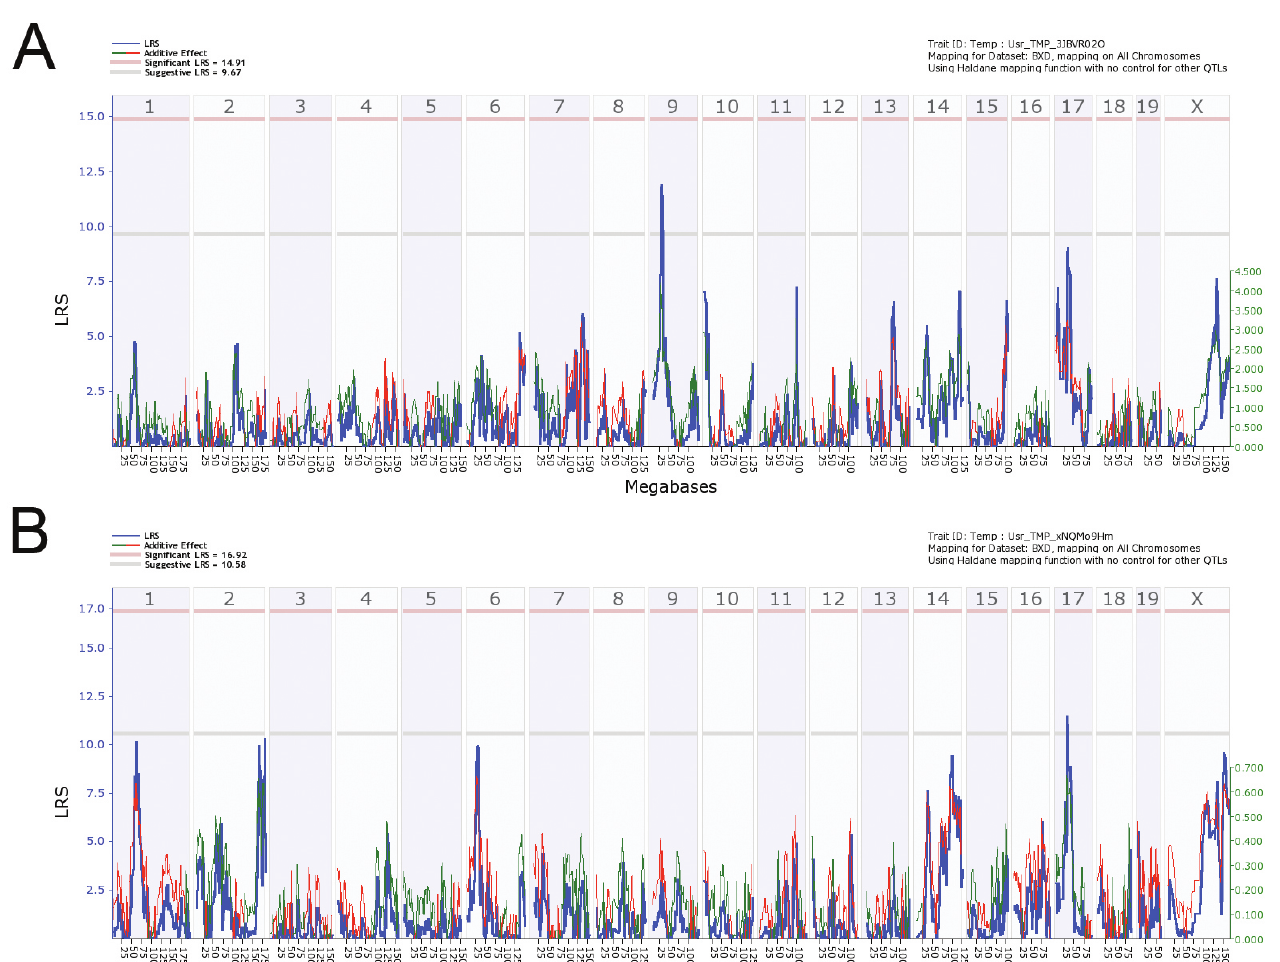
Figure 8. Comparison of preliminary genome-wide QTL mapped traits associated with differential response of BXD strains to aerosolized MA-EBOV. Interval mapping of percent weight loss at death (a) and maximum disease score (b) of BXD strains post-exposure to aerosolized MA-EBOV. Suggestive preliminarily QTLs were mapped. Proximal chromosome 9 is associated with percent weight loss at death (a) and proximal Chromosome 17 is associated with maximum disease score (b). (c) Preliminary QTL comparison of the three mapped traits associated with differential response to EBOV across BXD strains used. Chromosomes 17 and X are preliminary QTLs common for all three traits; chromosome 6 is most significant and associated with both differential survival and maximum disease score; chromosome 9 is associated with percent weight loss at death. Mouse chromosomes are depicted on the upper X-axis, and a physical map of each chromosome on lower X-axis (expressed in mega bases). The Y-axis shows significance of phenotype to genotype association expressed as LRS computed by WebQTL suite of GeneNetwork platform using 2000 permutation